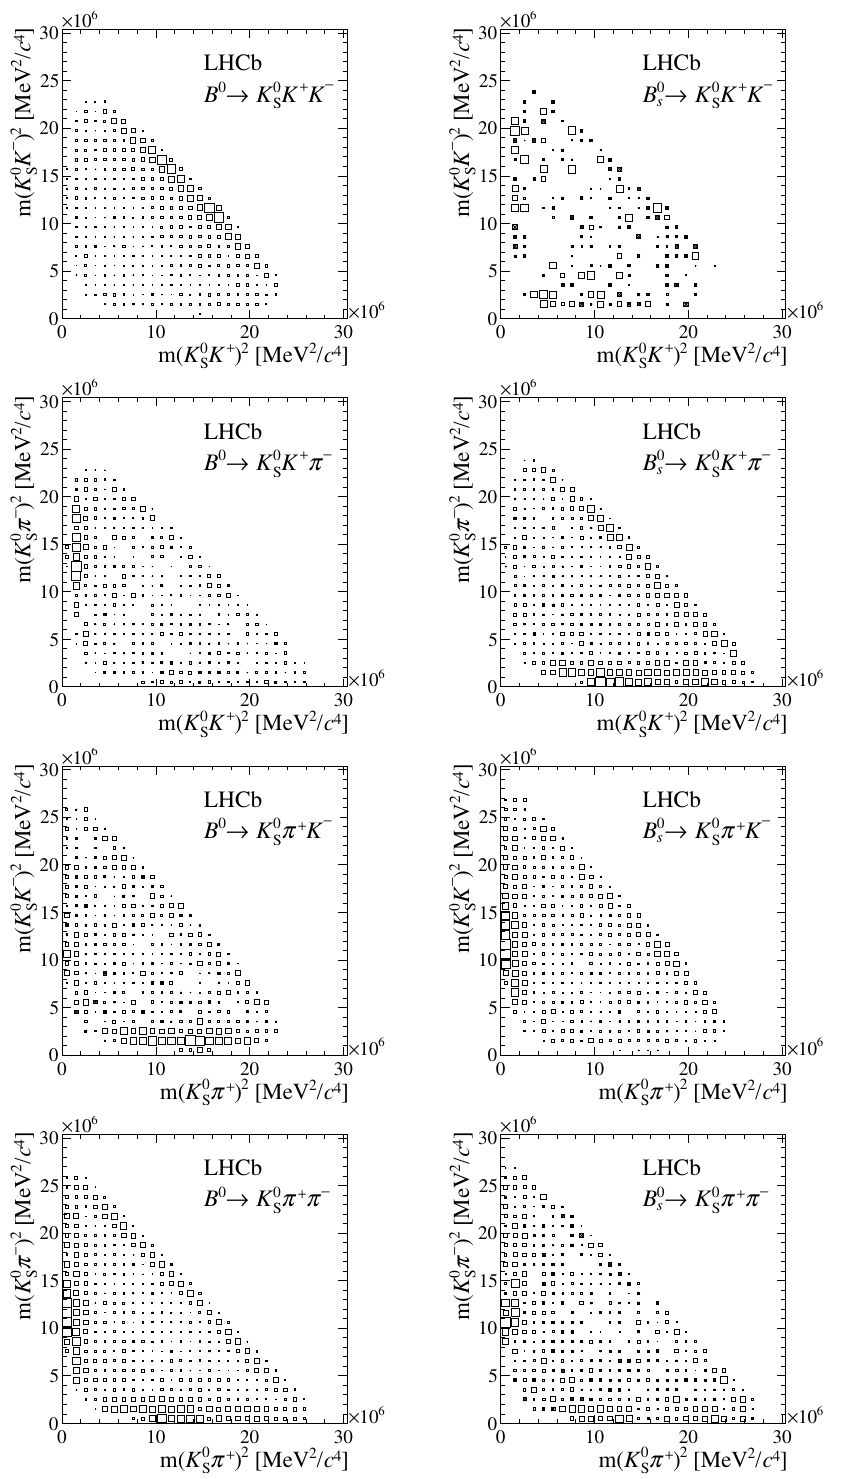
Figure 15 . Distribution of sPlot weights in data. The K 0 K 0 (cid:25) + (cid:25) (cid:0) (cid:12)nal states are shown from top to bottom, with a B 0 parent on the left, and a B 0 S right. All data-taking periods and K 0